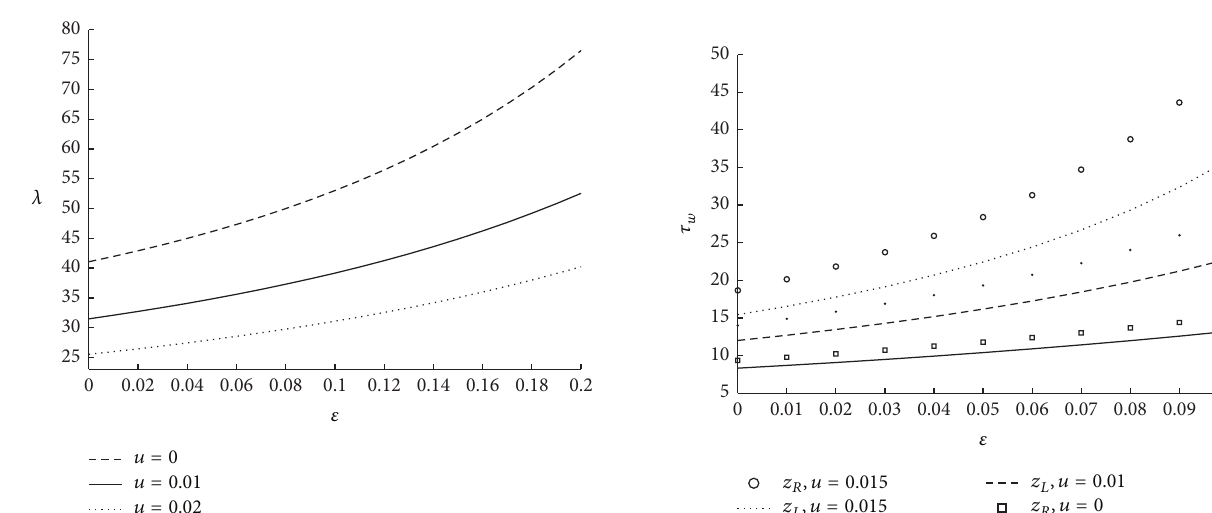
Figure 8: The variation of shear stress at wall with respect to 𝜙 at both maximum heights in the stenosis with fixed values of 𝑁 = 0.75 , = 0.1 , 𝑢 = 0.01 , and 𝑚 = 50 . 𝑟 𝑐